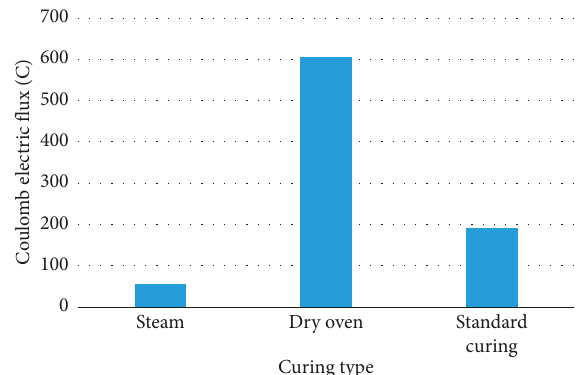
Figure 12: Chloride permeability test of concrete specimens with a W/B ratio of 0.4 prepared and cured under different conditions at a temperature of 50 °